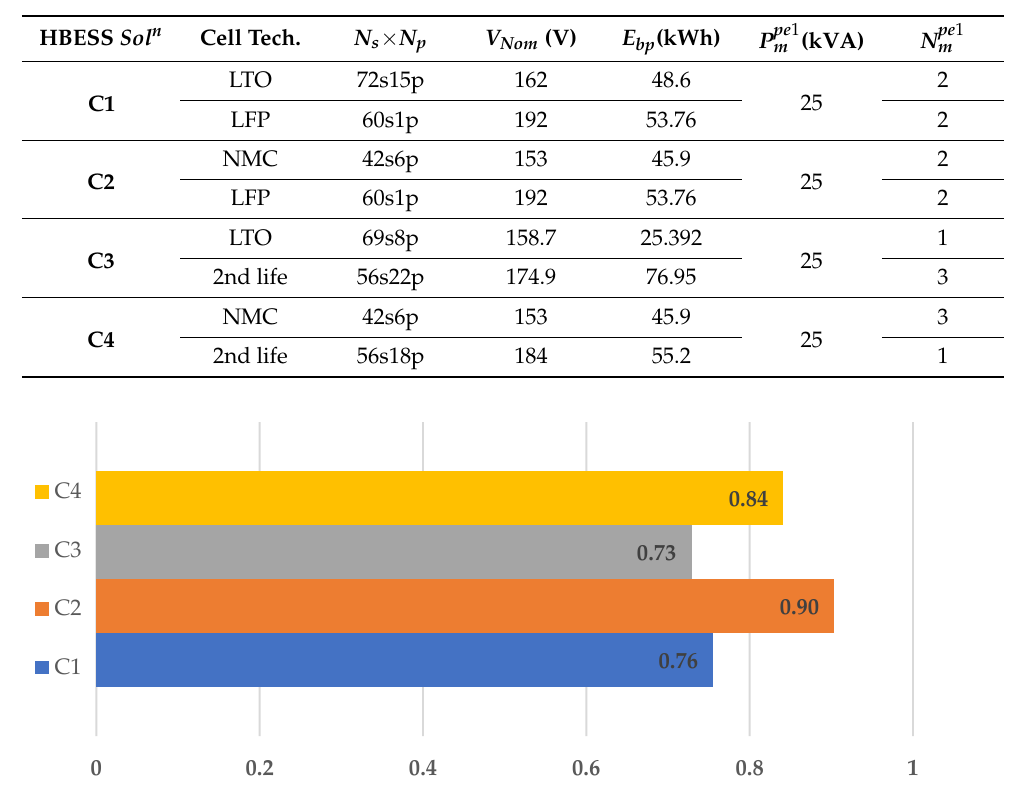
Figure 10. Pareto-optimal HBESS solutions found by the COF for TO-1. Table 6. Optimal hybrid system configuration solutions with the topology, TO-1.